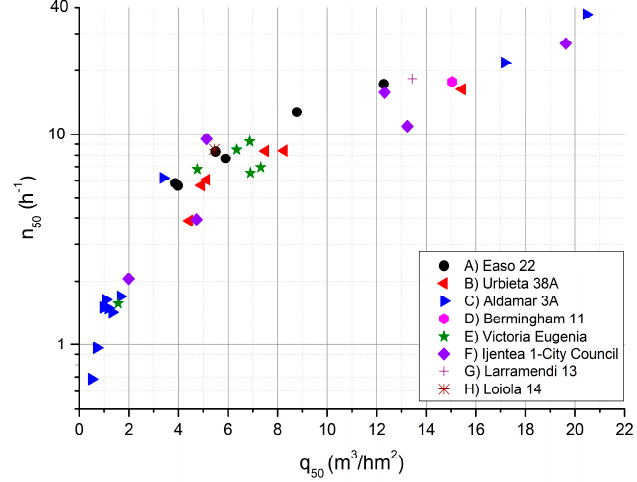
Figure 5. Distribution of the air tightness test results of the analyzed units by means of air permeability and air change rate at 50 Pa.